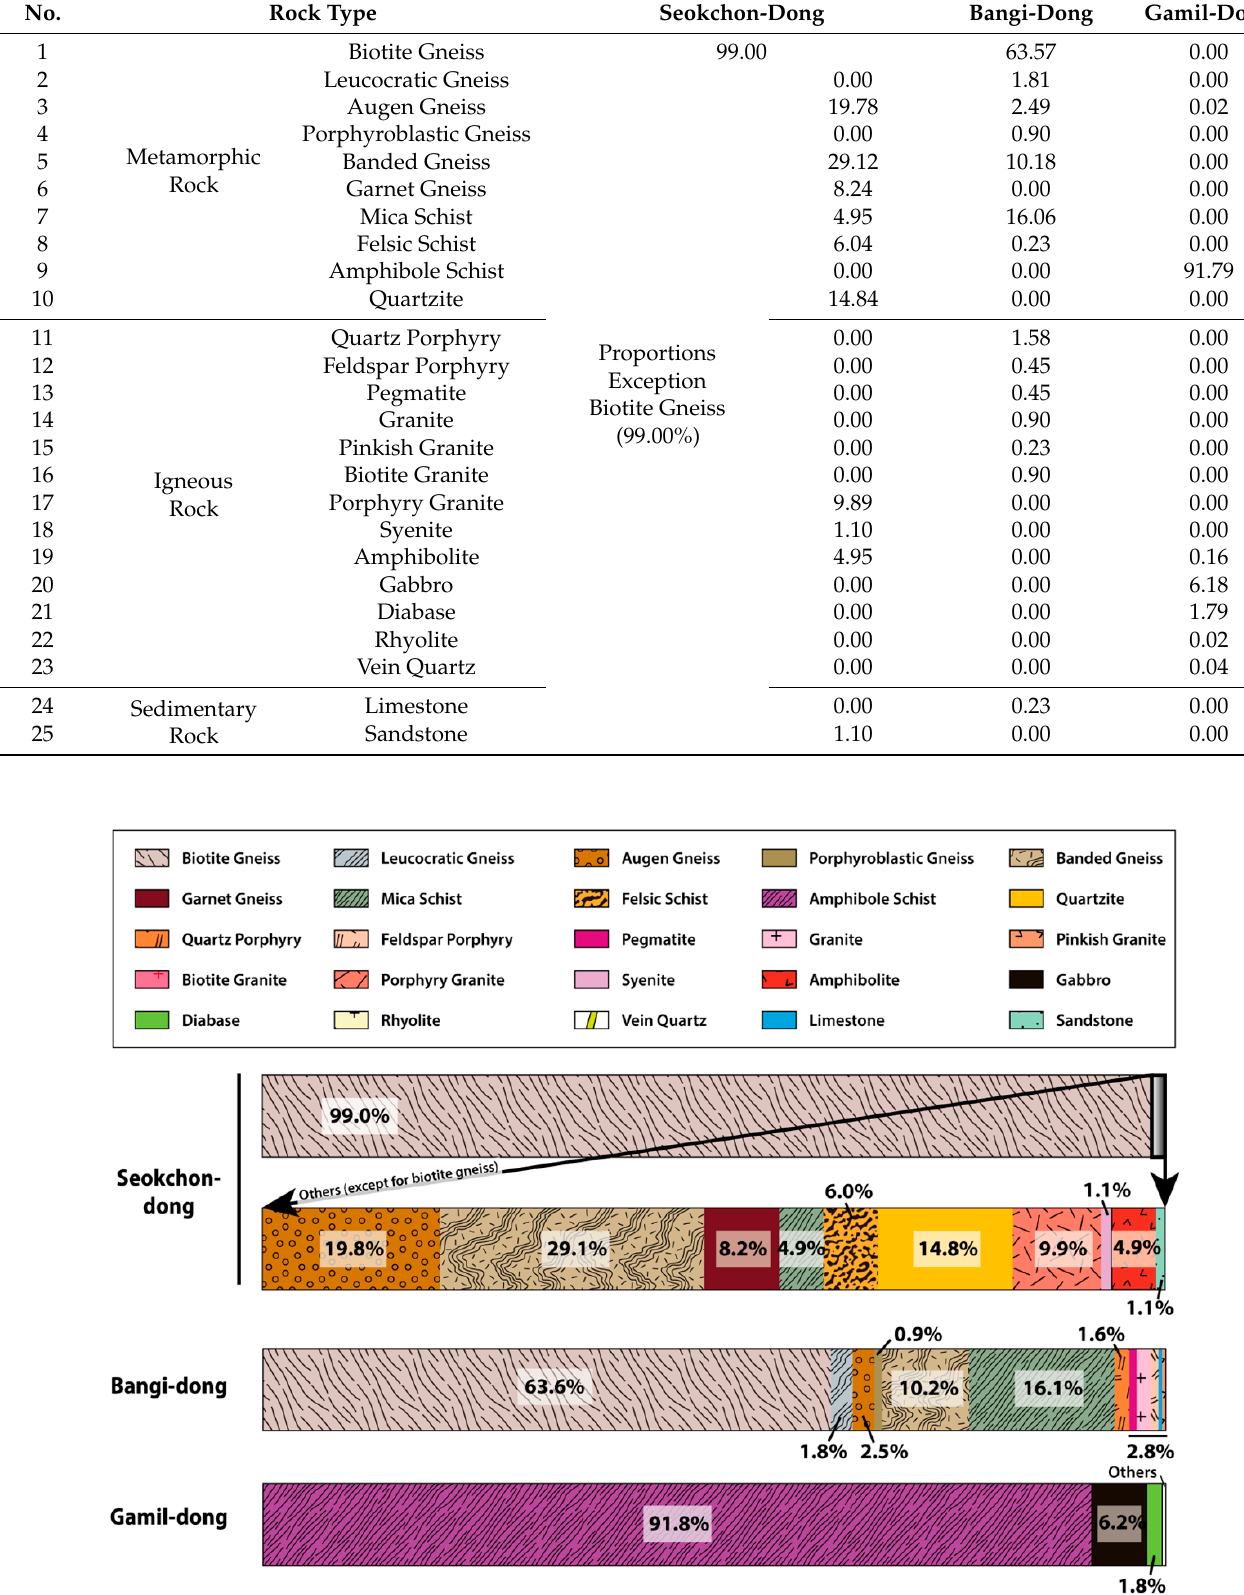
Figure 3. Proportions of rock types composing research target tombs.